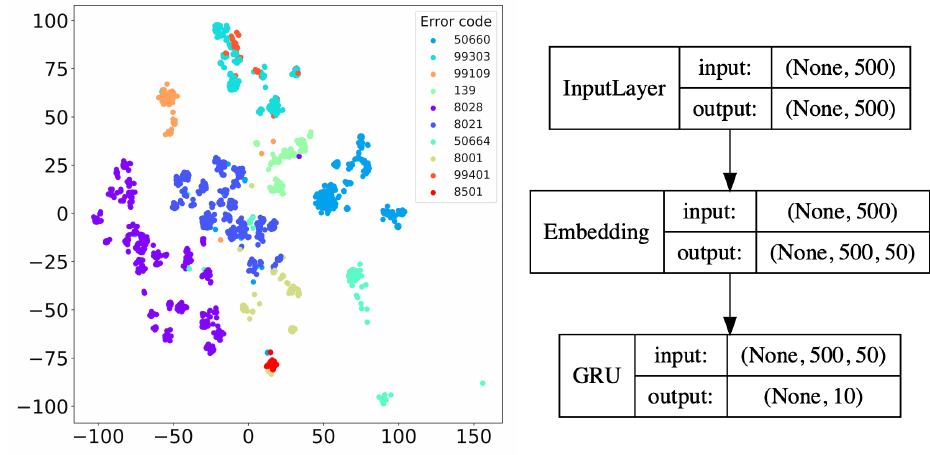
Figure 3: Left panel: output of the t-SNE algorithm for 5000 error log snippets after averaging the word vectors of each snippet. Right panel: sketch of a model that uses a GRU to obtain a numerical representation of a text